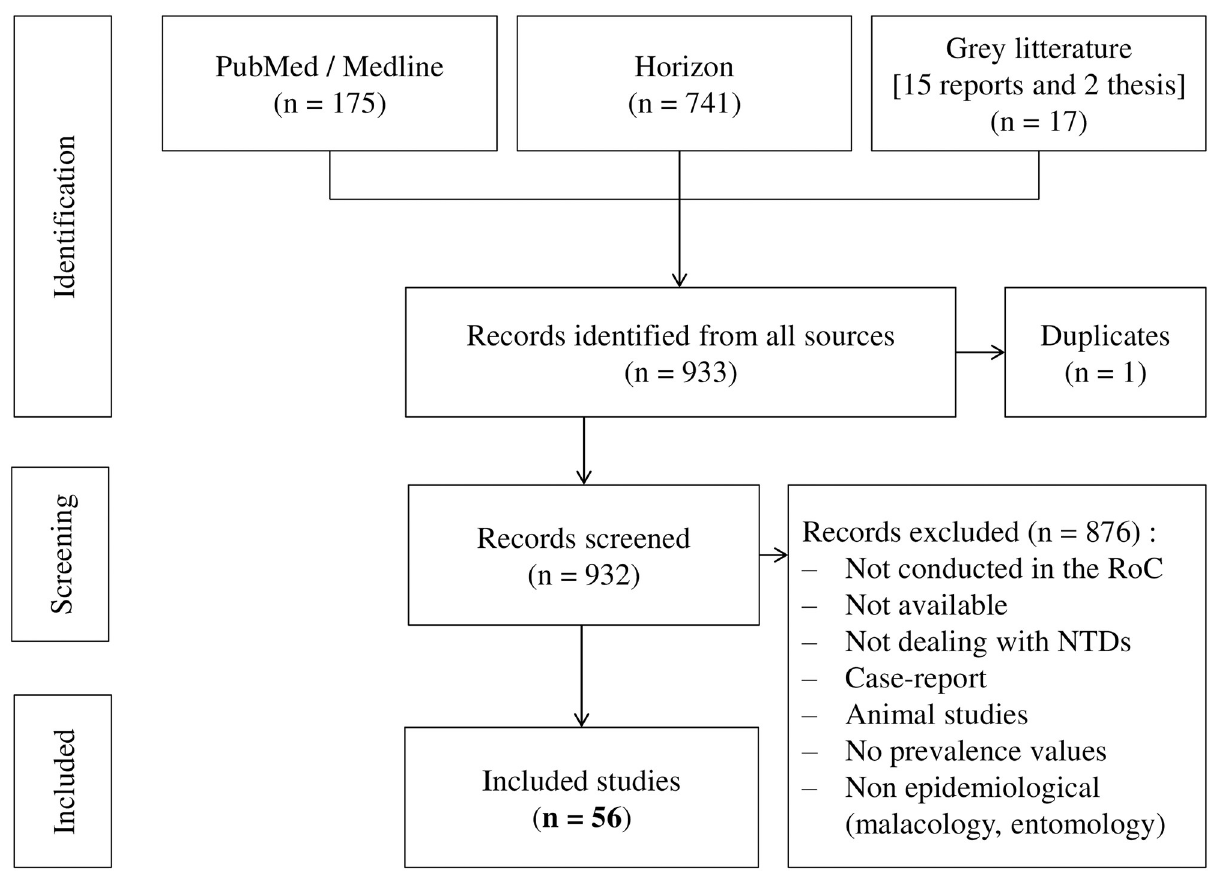
Fig 1. Flowchart of selected